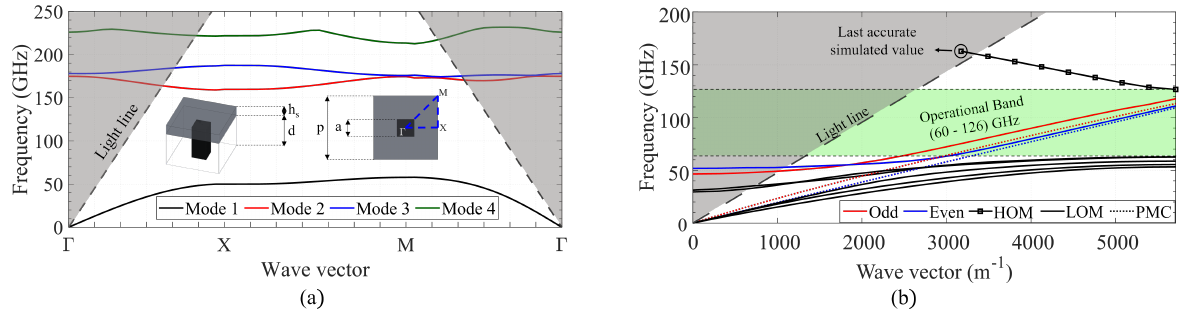
Figure 7. Dispersion diagrams. ( a ) Periodic bed of rectangular pins with a sketch of the unit cell dimensions. ( b ) Gap Coplanar Waveguide on 100 µ m silicon for a 1 mm lateral grounds extension. HOM: High Order Mode. LOM: Low Order Modes. Green area: bandwidth of